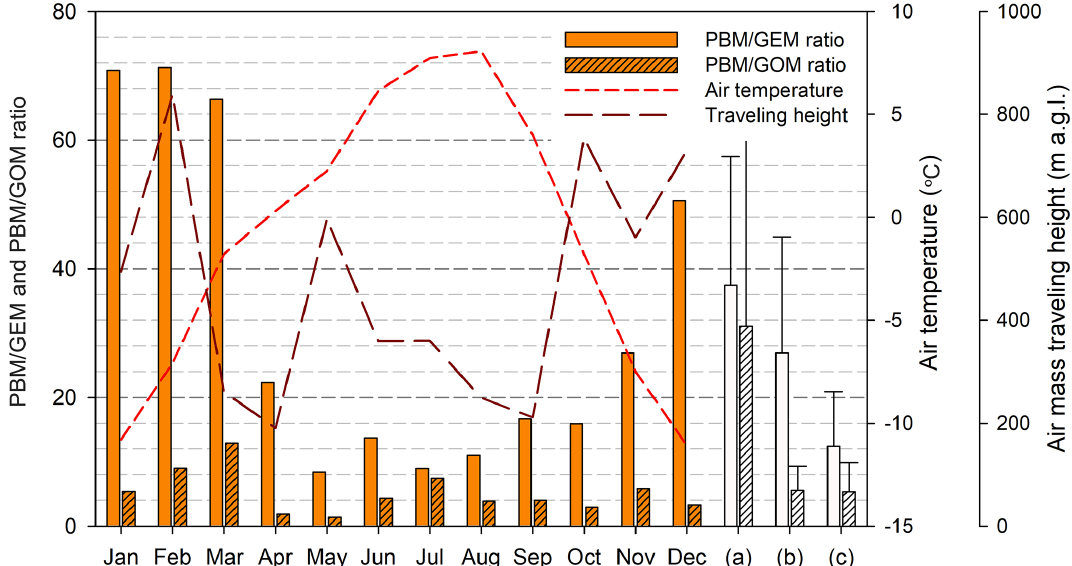
Figure 8. The monthly PBM / GEM and PBM / GOM ratio with air temperature and air mass traveling height during a full-year sampling period. Column (a) shows the mean PBM / GEM and PBM / GOM ratios at Qomolangma National Nature Preserve and Nam Co in the inland Tibetan Plateau, column (b) shows the mean PBM / GEM and PBM / GOM ratios of Chinese cities, and column (c) shows the mean PBM / GEM and PBM / GOM ratios of Chinese remote